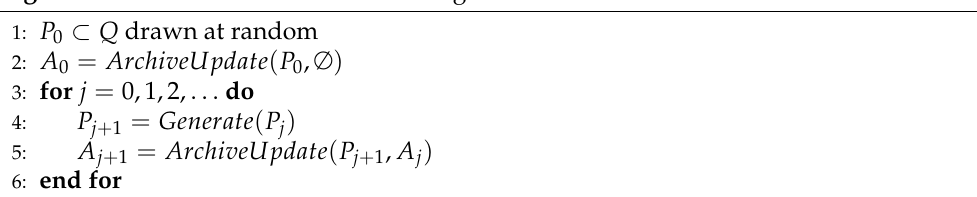
Algorithm 1 Generic Stochastic Search